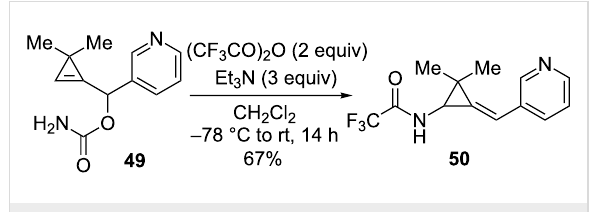
Scheme 18: Formation of trifluoroacetamide 50 from carbamate 49